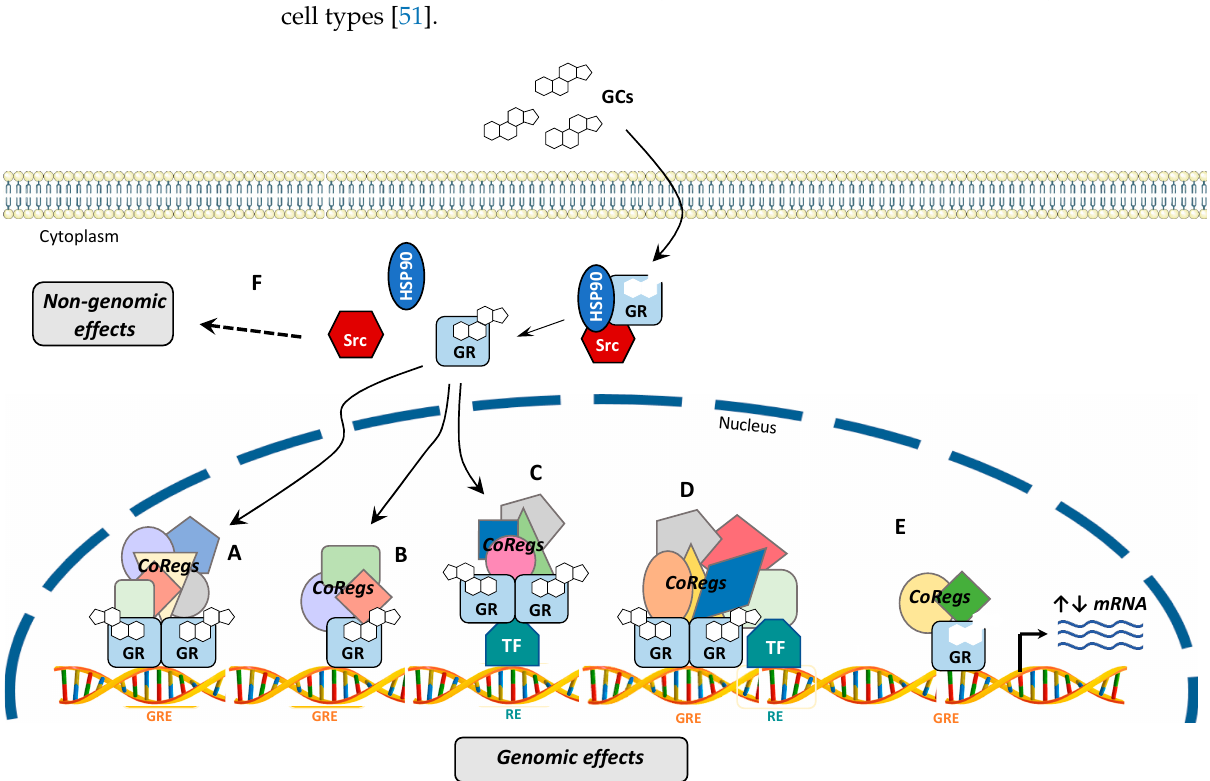
Figure 4. Genomic GR signaling. Upon ligand binding, GR undergoes a conformational change, dissociates from chaperone proteins (HSP90), and translocates into the nucleus, where it can bind directly to DNA as a dimer on a specific GR response element (GRE) ( A ), as a monomer through a simple GRE ( B ), through other transcription factors (TFs) by tethering itself to the TF ( C ), or in a composite manner by directly binding to GRE ( D ). Unliganded GR modulates cell signaling in the absence of GCs ( E ). In addition to the genomic action of GR in the nucleus ( A – E ), when GR dissociates from its cytoplasmic complex upon GCs treatment, it can also regulate non-genomic effects ( F ). Specific sets of coregulators are recruited, resulting in the activation or repression of target genes, regulating specific biological functions.